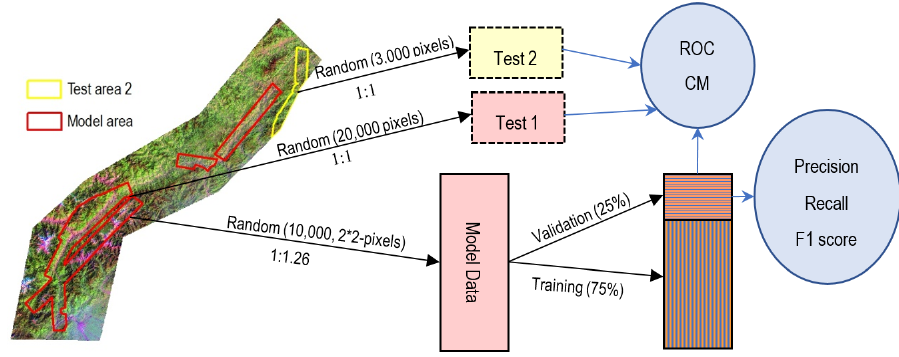
Figure 10. A flowchart shows how training, validation, and testing samples were created. The ratio under the arrow shows the ratio of select landslide and non-landslide pixels.